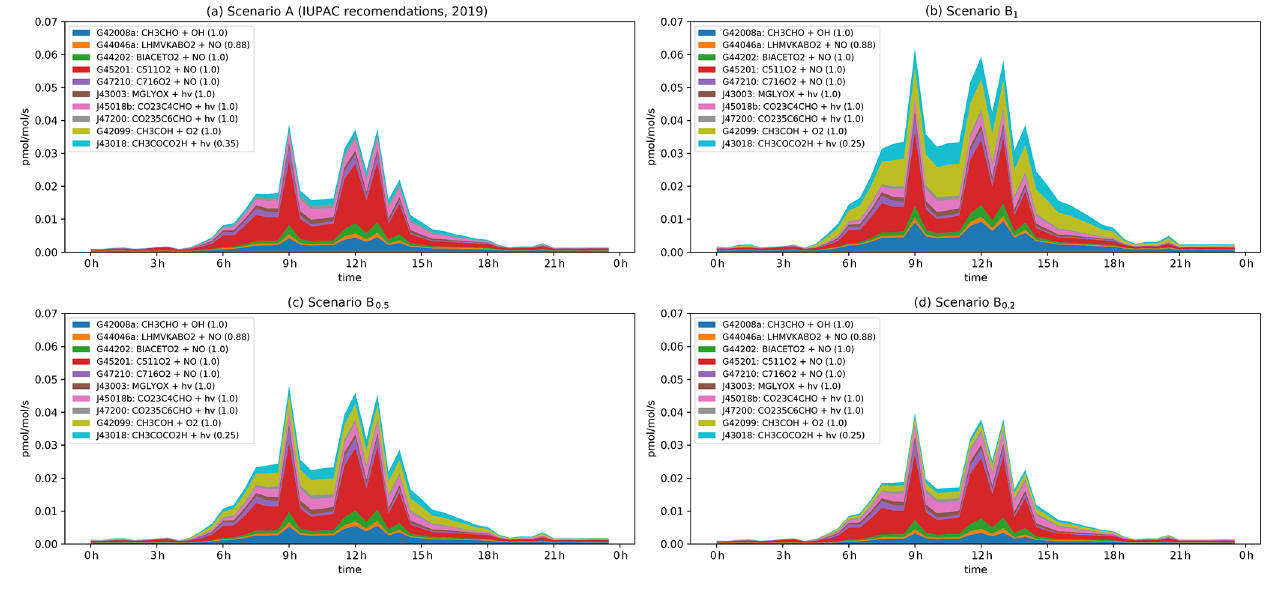
Figure 7. Modelled rates of CH 3 CO formation (in pptvs − 1 ) through the diel cycle from photolysis of pyruvic acid (blue, orange, and green) and other photochemical processes during IBAIRN. (a) Scenario A (IUPAC). (b) Scenario B 1 . (c) Scenario B 0 . 5 . (c) Scenario B 0 . 2 . In the legend, the first term is the equation tag used by CAABA/MECCA for the reaction. A full listing of the reactions can be downloaded (see Data availability section).